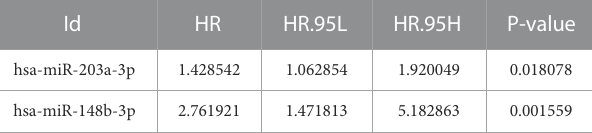
TABLE 3 miRNAs associated with TNBC overall survival time were obtained from univariate Cox regression analysis.